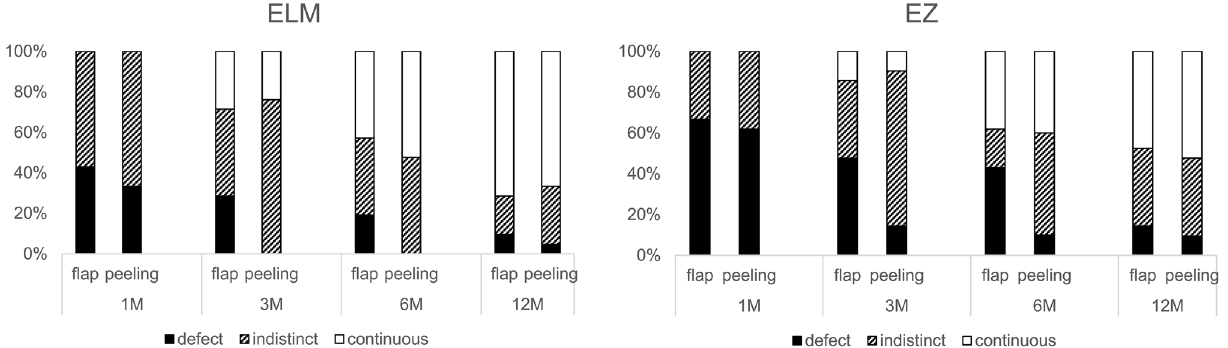
Figure 3. Recovery of the external limiting membrane (ELM) and ellipsoid zone (EZ) in the flap group and the peeling group at 1, 3, 6, and 12 months after